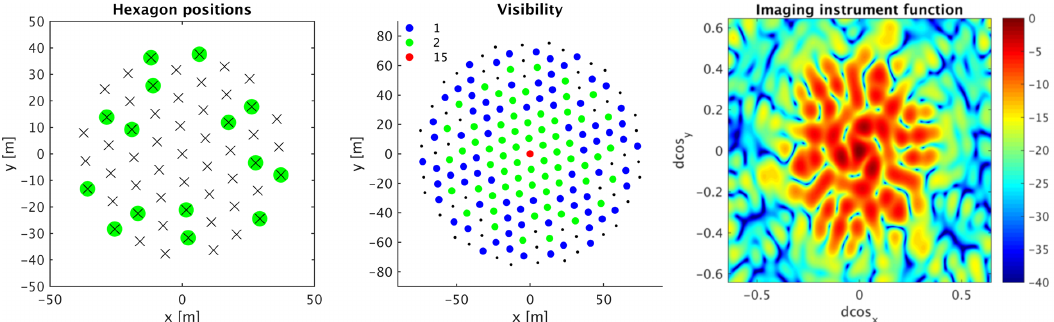
Figure 1. Left: the receiving configuration of the imaging configuration in June 2015 is indicated by green circles. All possible receiving locations are indicated by black crosses. Middle: visibility function (as referred to by astrophysicists) for the imaging configuration. All possible baselines are indicated by black dots, and the colour code is the number of redundant baselines of the configuration used for imaging. Right: instrument function of the 15 hexagons indicated in the left panel. dcos is the direction